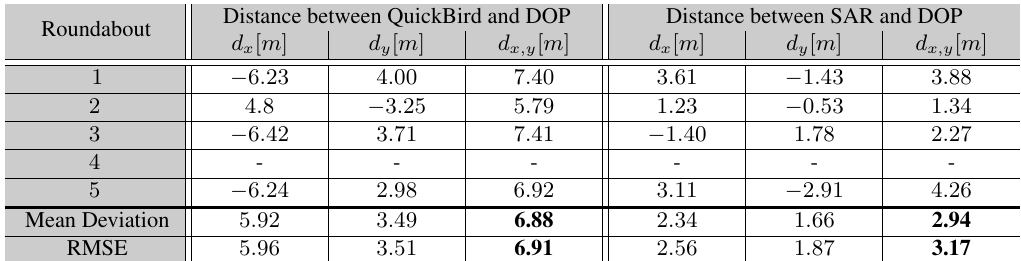
Table 3. The distances d x and d y in x - and y -direction, the Euclidean distances d x,y , between the detected roundabout centers of the QuickBird and reference image, respectively the SAR and reference image, the mean deviation and, the root mean square error (RMSE). The x -direction corresponds to east and the y -direction to north. Distance between WorldView- 2 and DOP Distance between SAR and DOP Roundabout